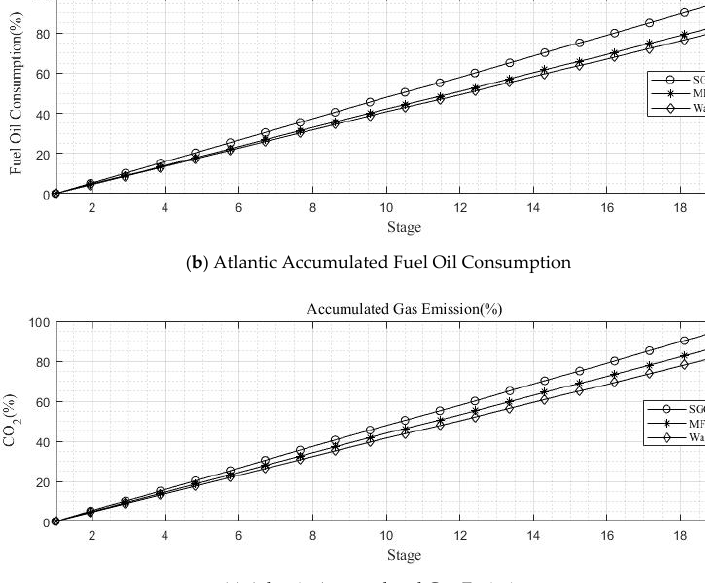
Figure 18. The Atlantic voyage and Pacific voyage planning results. Table 10. The Atlantic case—accumulated FOC and gas emission results.